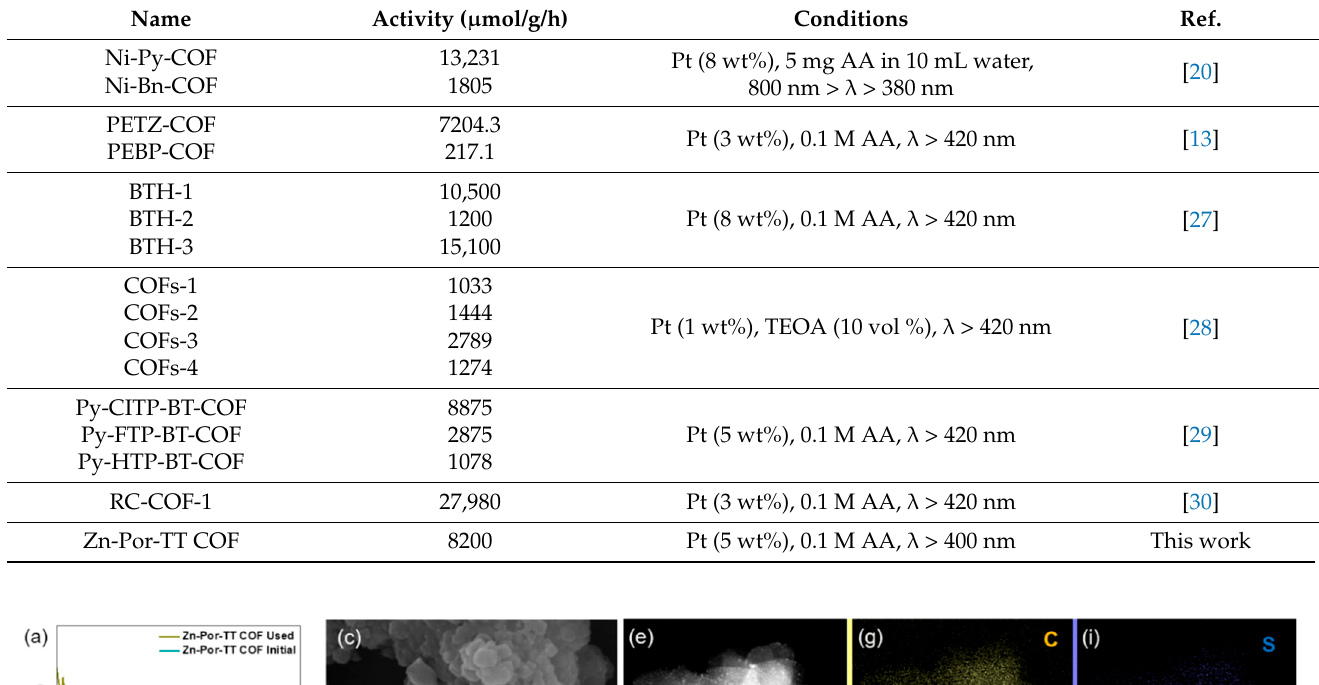
Table 1. The photocatalytic performance comparison of Zn-Por-TT COF with other representative COF based photocatalysts.